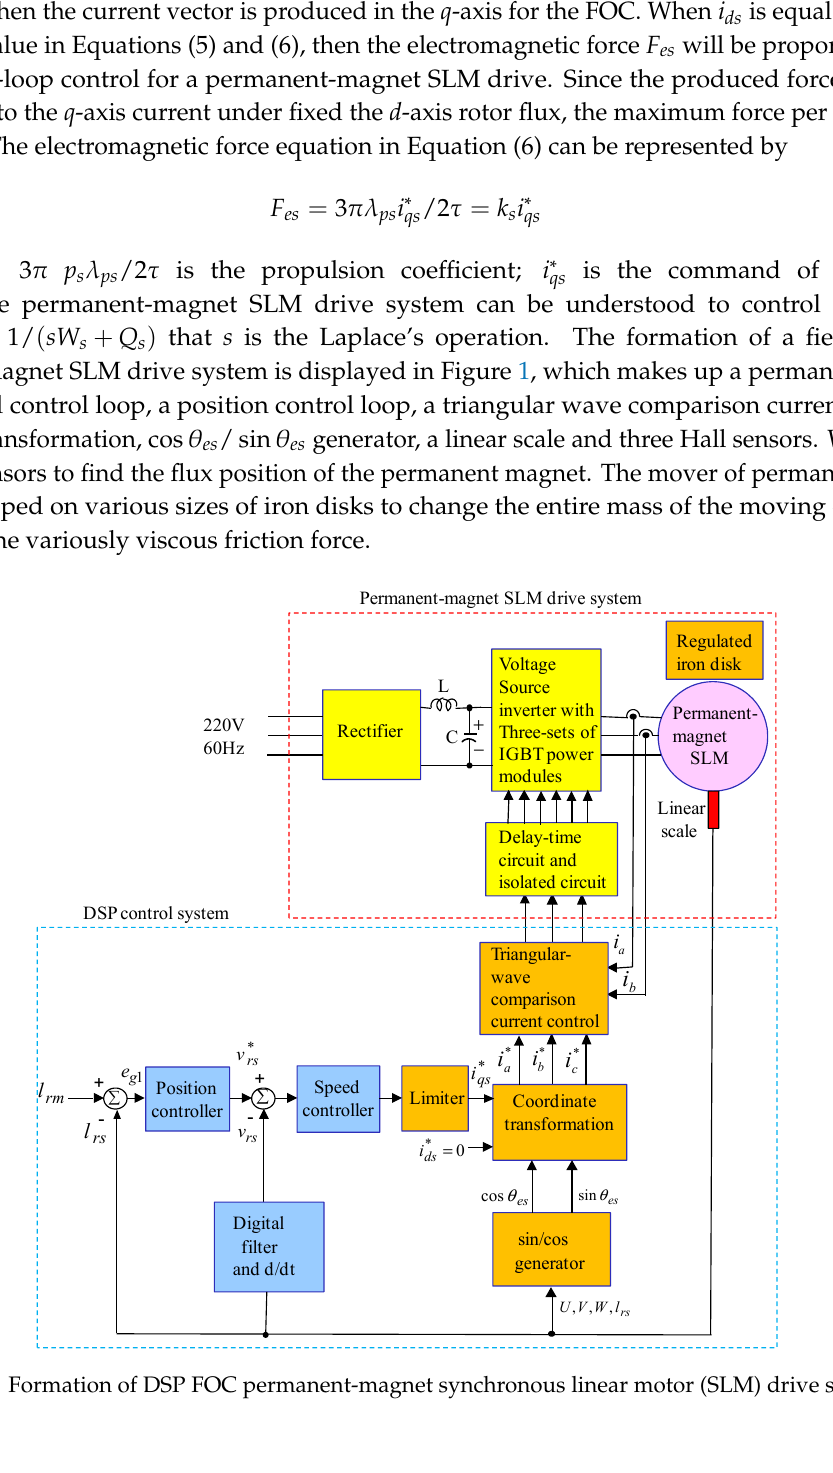
Figure 2. Block diagram of understood control system. 3. Design of the AMRRSPNNB Control System with Reimbursed Controller and DGWO When the actual permanent-magnet SLM drive system operates with parameter variations, external load disturbance, friction force, wind resistance force, flux saturation force and cogging force is acted, then Equation (7) can be rewritten by